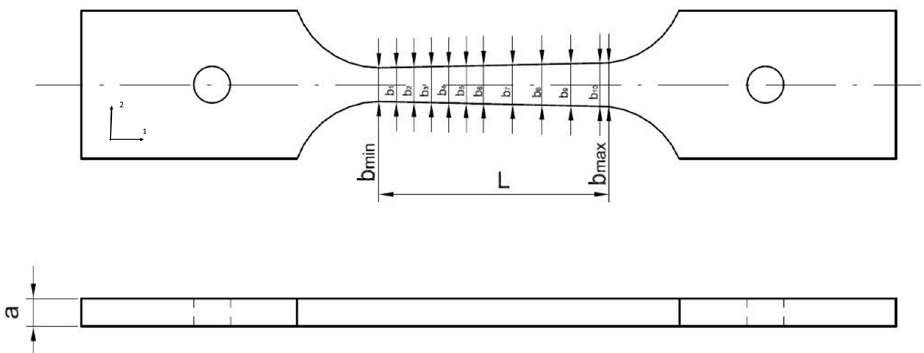
Figure 2. Specimen with varying cross-section of the gage part used for the investigation (dimensions in mm).